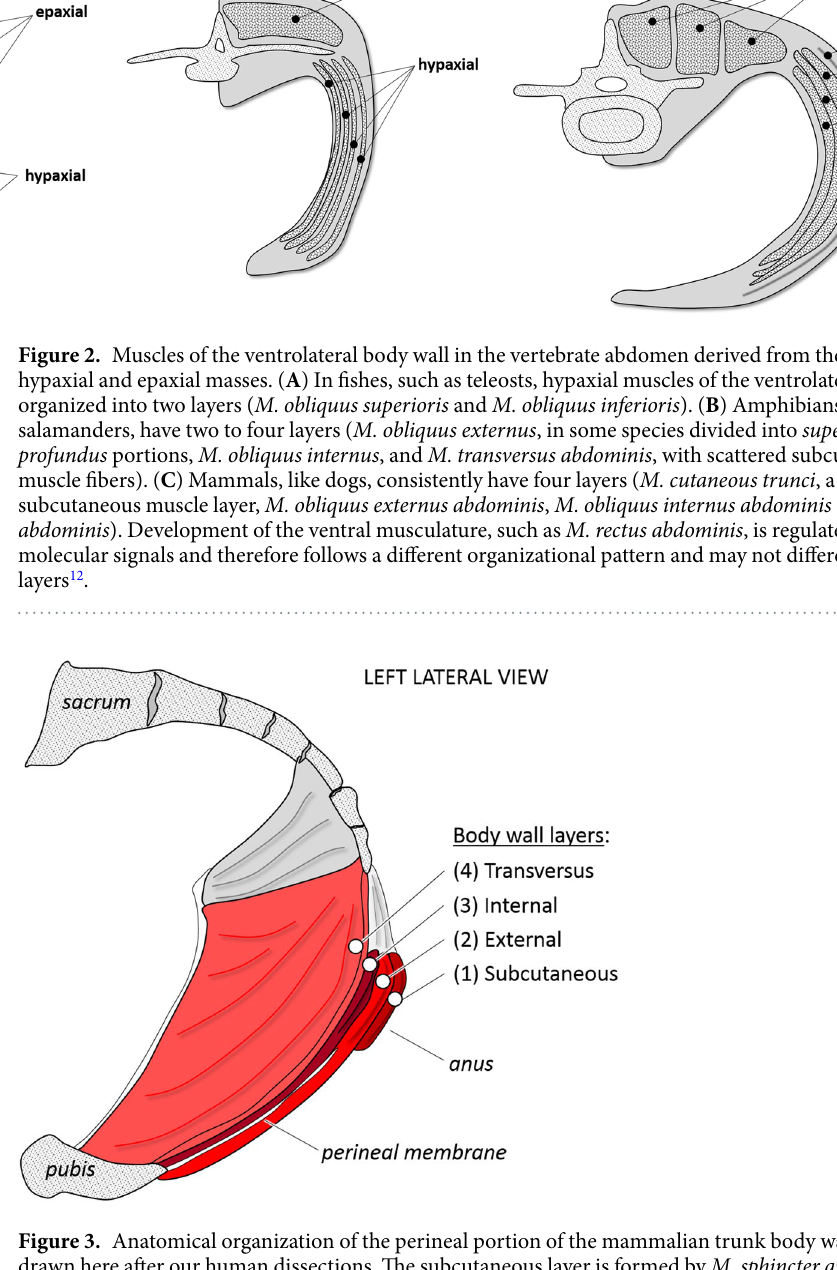
led to novel anatomical adaptations in mammals relative to other vertebrates. Specifically, mammals alone among vertebrates evolved the suite of characteristics from the anorectal and urogenital chambers formed by cloacal sep- tation including the rectum, anal canal, urethra, and paired vascular erectile tissues. Other vertebrate intromis- sion structures, such as those variably found in some fish, lizards, turtles, crocodilians, and waterfowl, arise from the cloacal wall and have either a single vascular erectile body or one engorged with lymph, and are not homol- ogous to mammalian genitalia 33–35 . Lizards, crocodilians, birds, and even monotremes have muscular sphincters that regulate opening of the cloaca 9, 11, 36 . These cloacal muscles, as well as perineal muscles in mammals, were proposed to evolve from abdominal trunk muscles in previous studies 37, 38 . However, anatomic, embryonic, and molecular investigations indicate that, while cloacal muscle precursors temporarily reside in the limb, they later